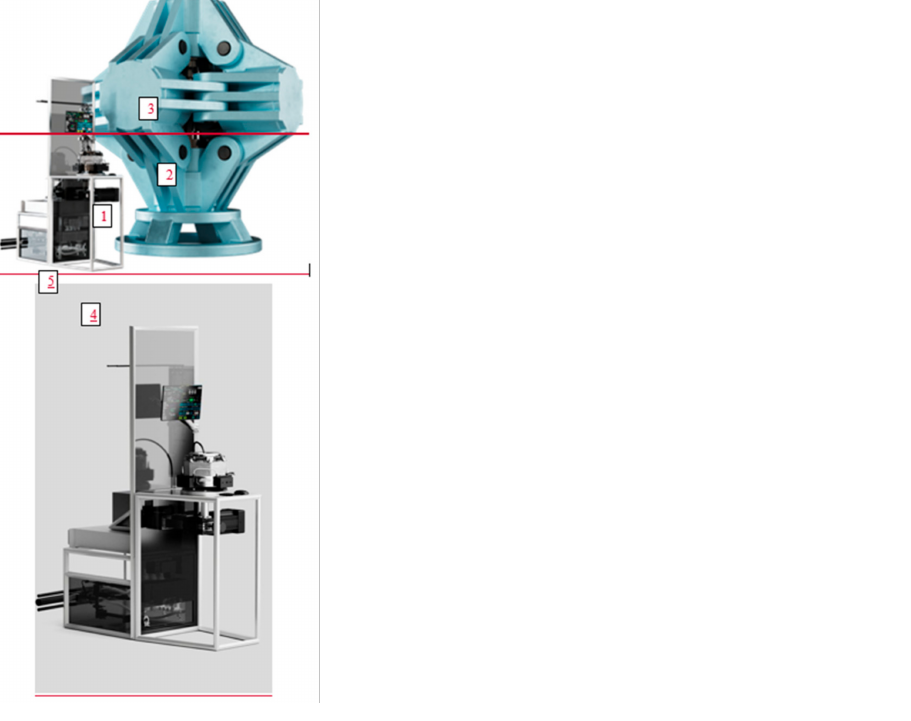
Figure 2. A diagram of 2.45 GHz MP CVD reactor. We can see a magnetron (1), a chamber (where diamonds grow, (2), control panel (3), pumps (4), electric, gas, and refringent supply cables